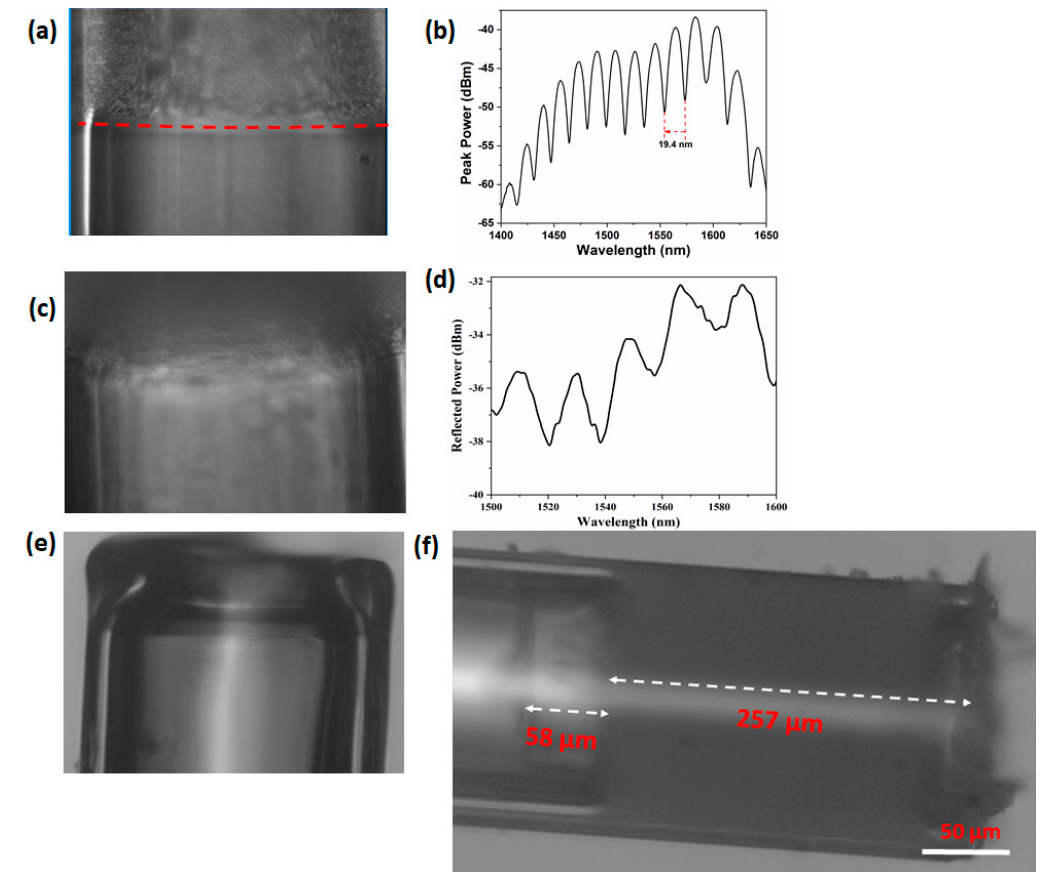
Figure 3. Optical microscopic images of the inner surface of the SR films formed at the tip of capillary after spin coating at rotational speeds of 4800 rpm ( a ) and the corresponding interference pattern ( b ); 3000 rpm ( c ) and the corresponding interference pattern ( d ). Tip of the capillary with no SR film after spin coating at a rotational speed of 5900 rpm ( e ). Optical microscopic image of fabricated probe corresponding to rotational speed of 4800 rpm ( f ).